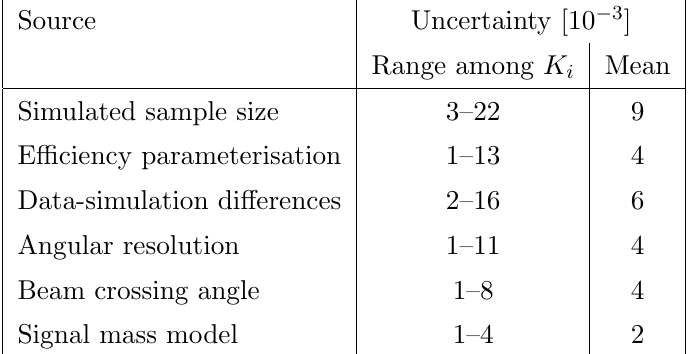
Table 2 . Sources of systematic uncertainty on the K i angular observables, together with the mean and the range of uncertainty values assigned to the 34 K i parameters in each case. The variation of each source of systematic uncertainty between the di(cid:11)erent observables depends on the structure of the weighting functions used to extract the observable and its correlation with the angular e(cid:14)ciency.